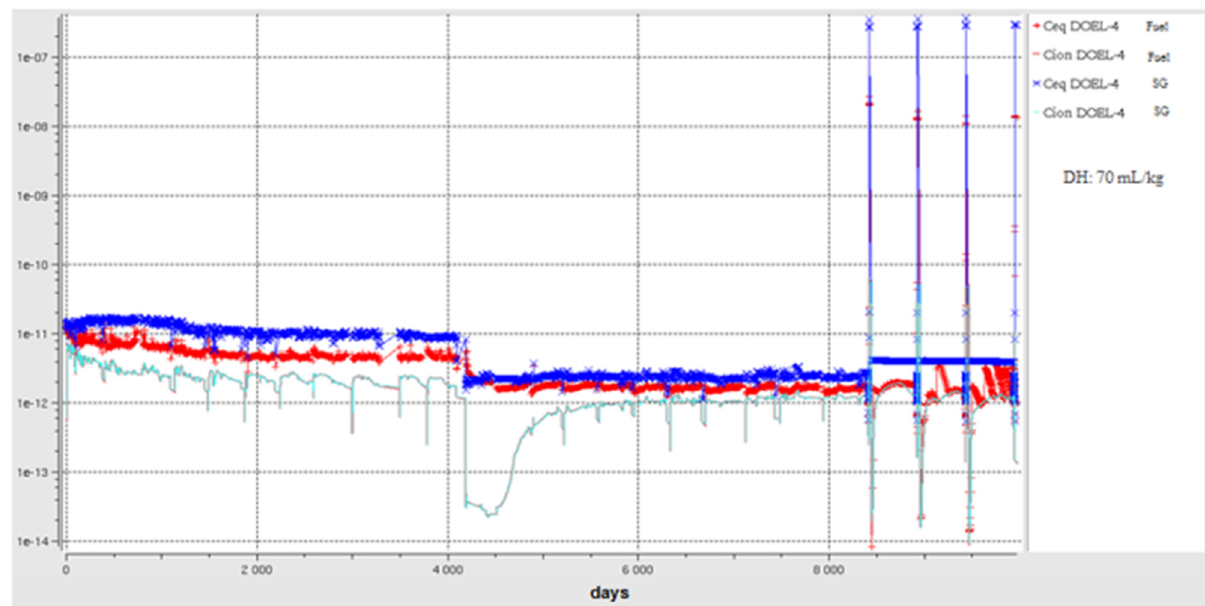
Fig. 10. OSCAR V1.3 calculation (cid:2) Comparison between Co equilibrium concentrations (Ceq) and Co concentrations in solution (Cion) inside the hottest fuel and SG cold side regions with a DH value of 70 mL/kg.